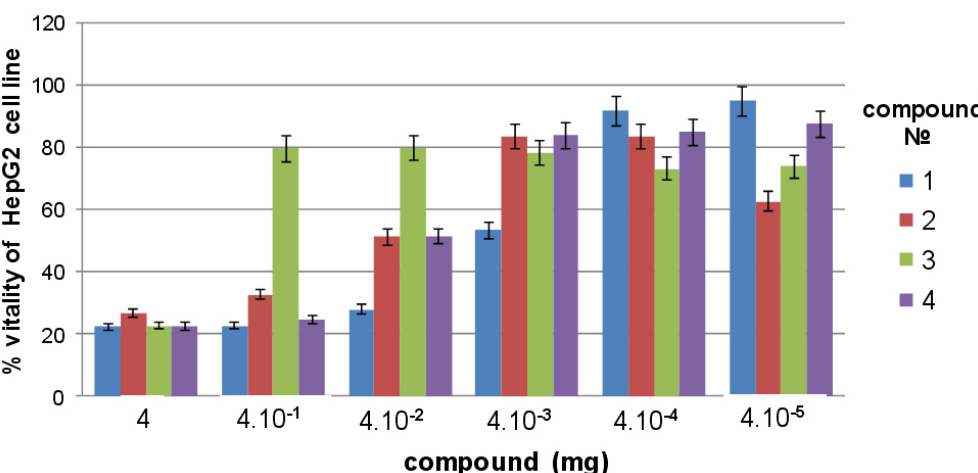
Figure 5. Vitality (%) of human differentiated hepatocellular liver carcinoma HepG2, treated with substances 1- 4